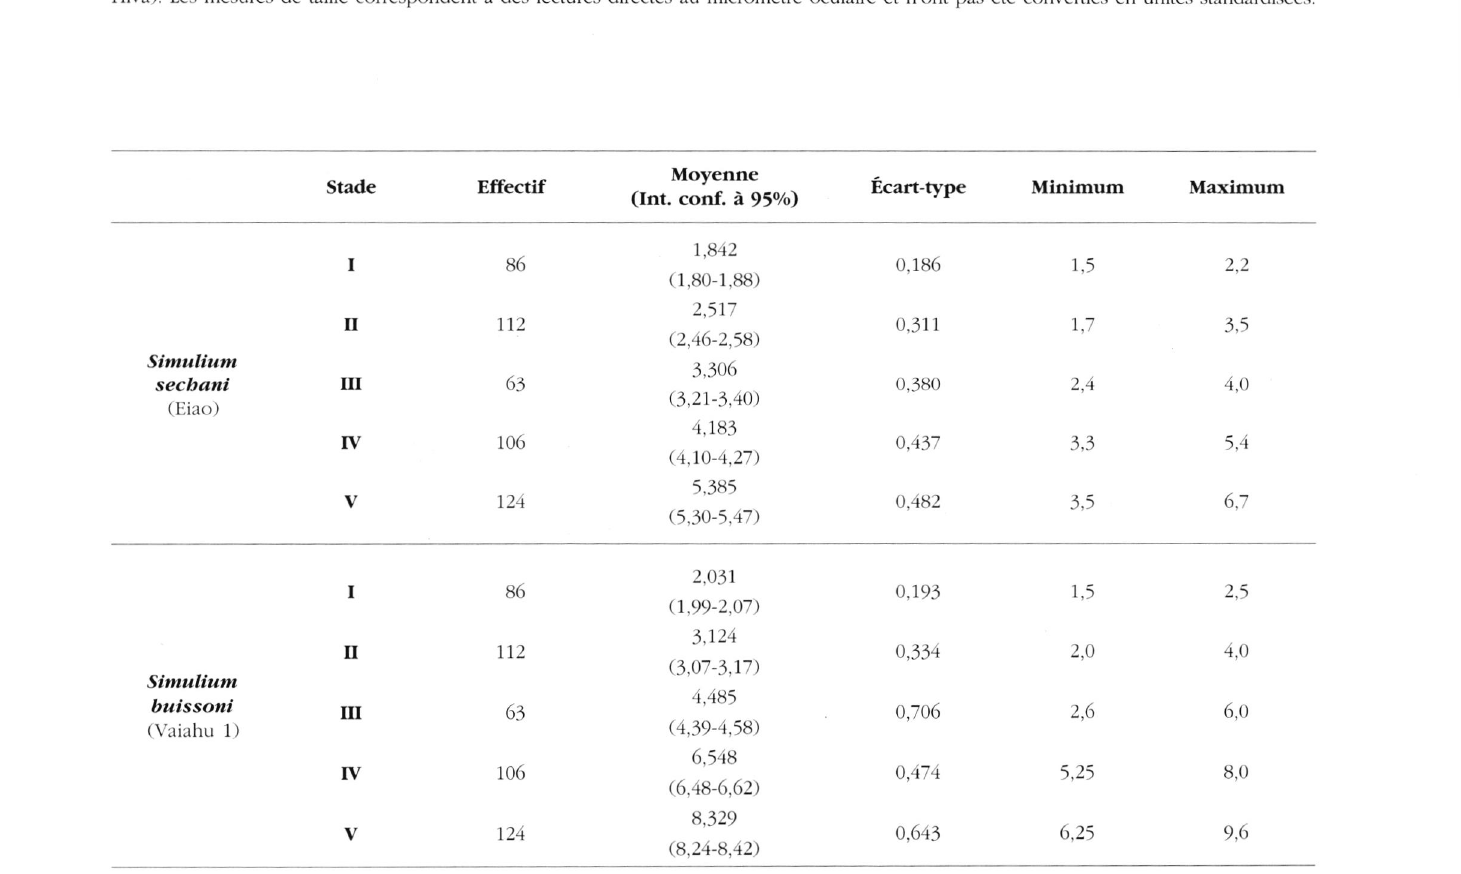
Tableau II. - Caractéristiques du paramètre "a" des cinq premiers stades de S. sechani (Vaituha : Eiao) et de S. buissoni (Vaiahu 1 : Nuku- Hiva). Les mesures de taille correspondent à des lectures directes au micromètre oculaire et n'ont pas été converties en unités standardisées